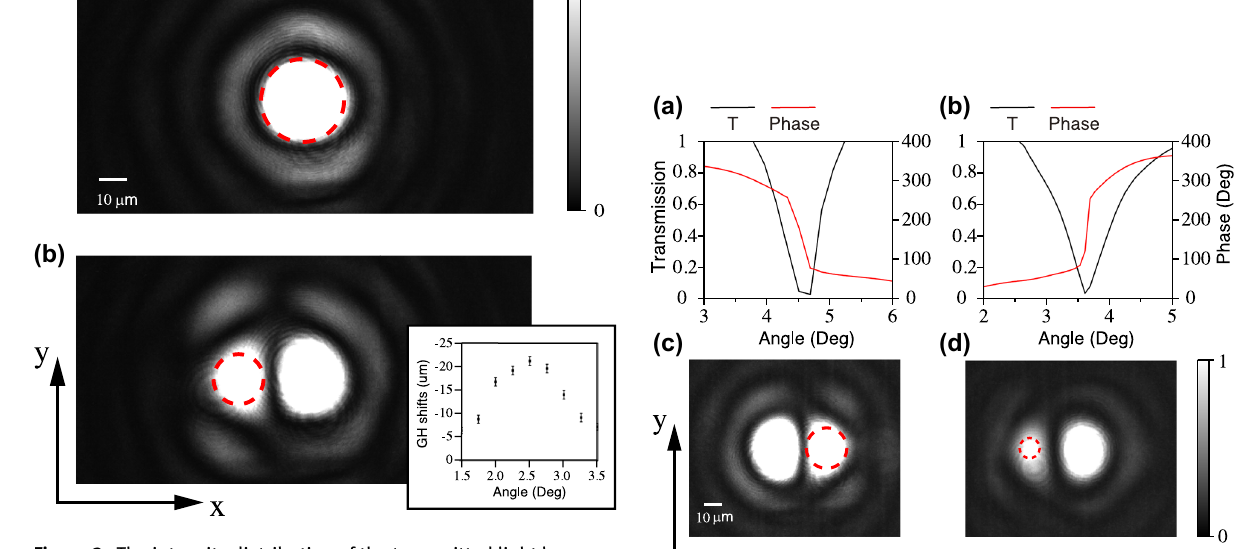
Figure 3: The intensity distribution of the transmitted light beam measured experimentally. (a) Transmitted beam image with TE polarized at 660 nm passing through unstructured Si The dashed red circle is the region of interest. (b) Beam image passing through the fabricated gratings. The other conditions are the same in (a). The inset at the bottom-right corner indicates transmitted optical GH shift angular spectra.